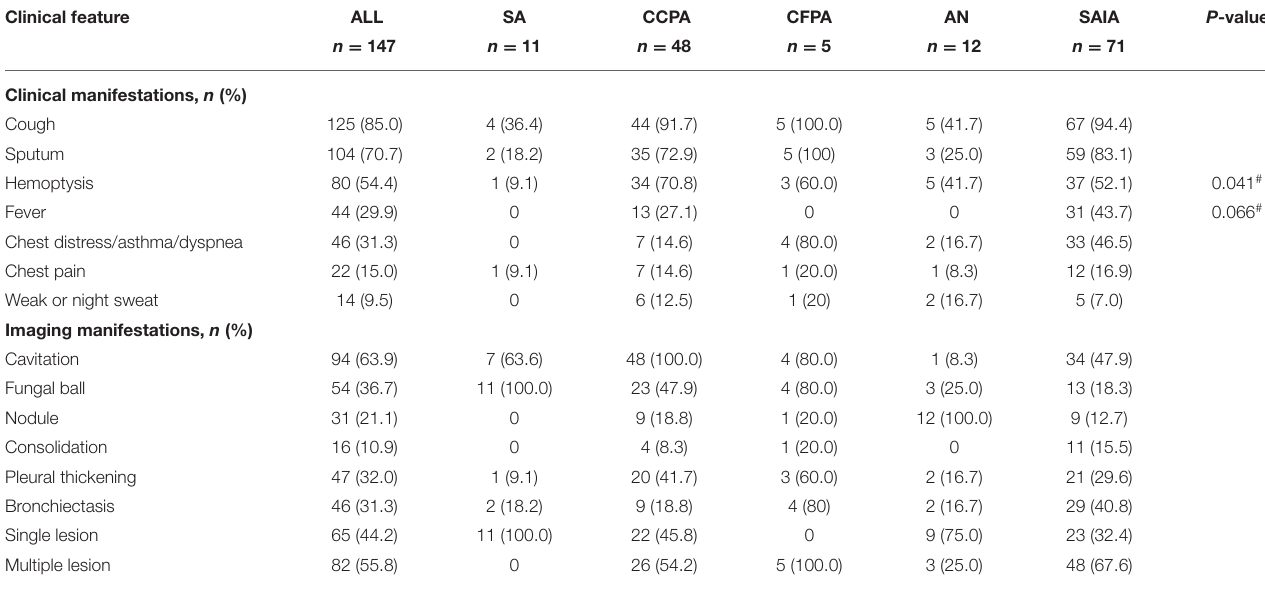
TABLE 2 | The clinical and radiological manifestation of patients with CPA in different subtypes. Clinical feature